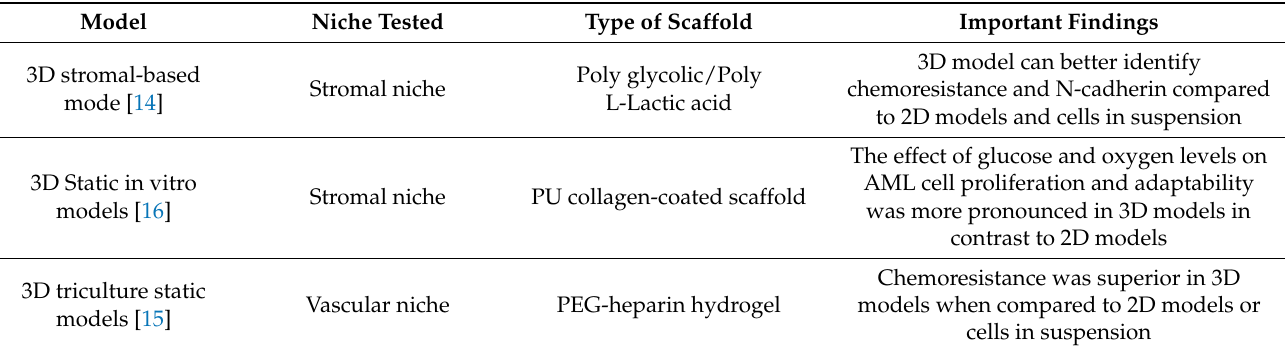
Table 1. Comparison between synthetic scaffold-based 3D